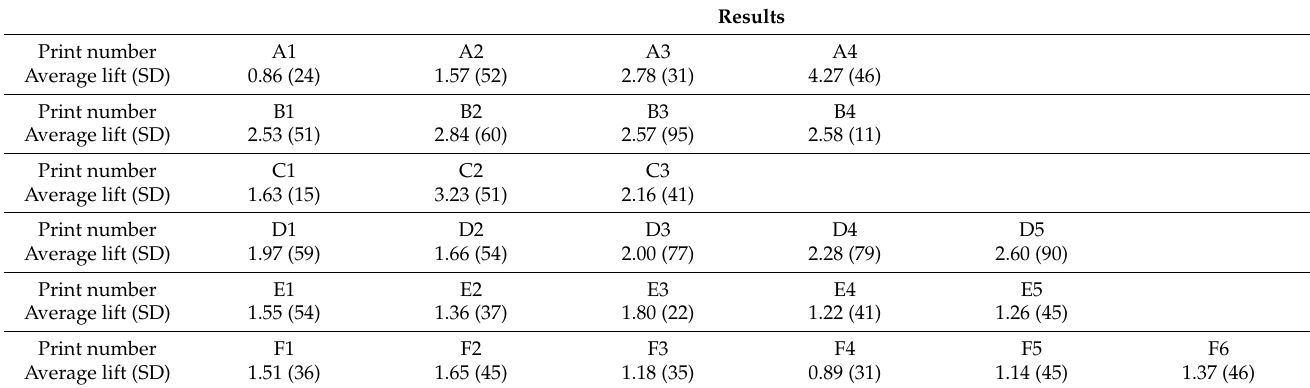
Table 4. Results of the measurements of average vertical lift for each printout in mm.